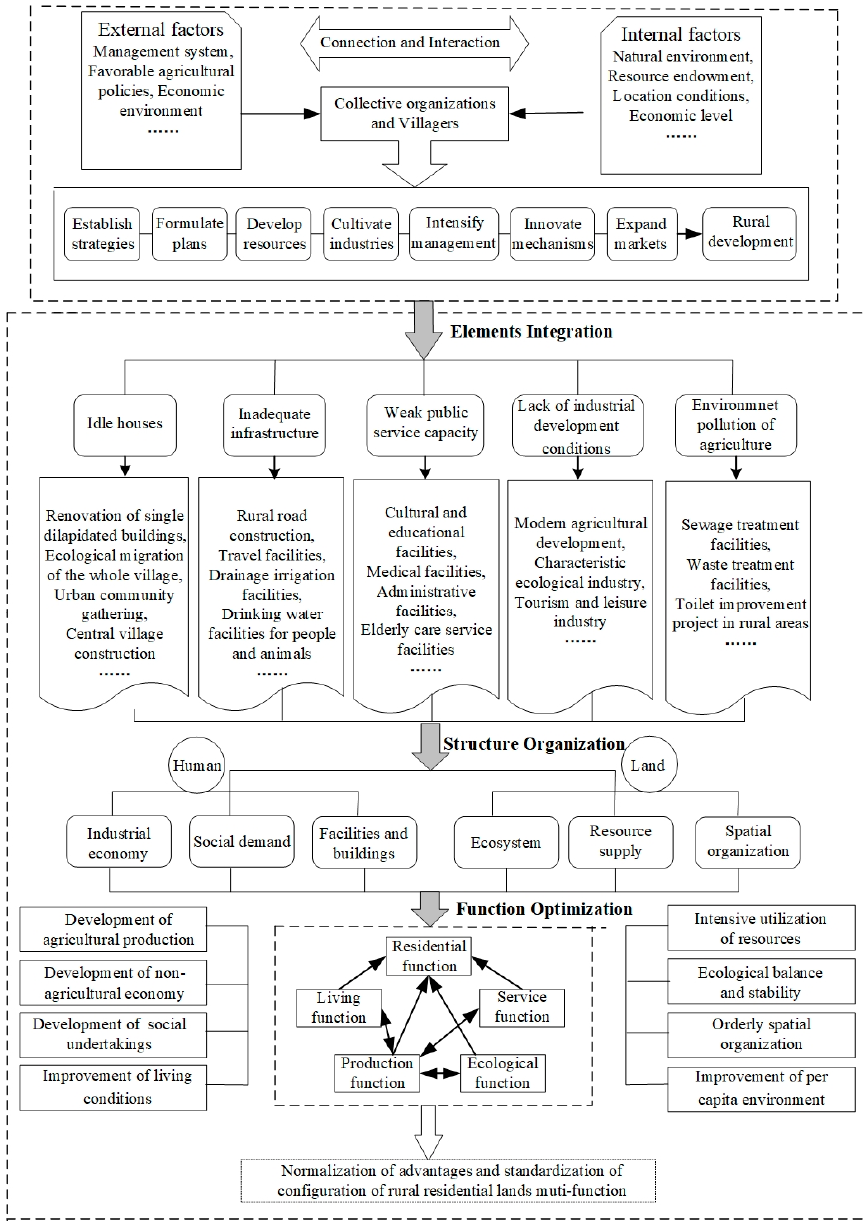
Figure 6. Process mechanism of function optimization of rural residential land.